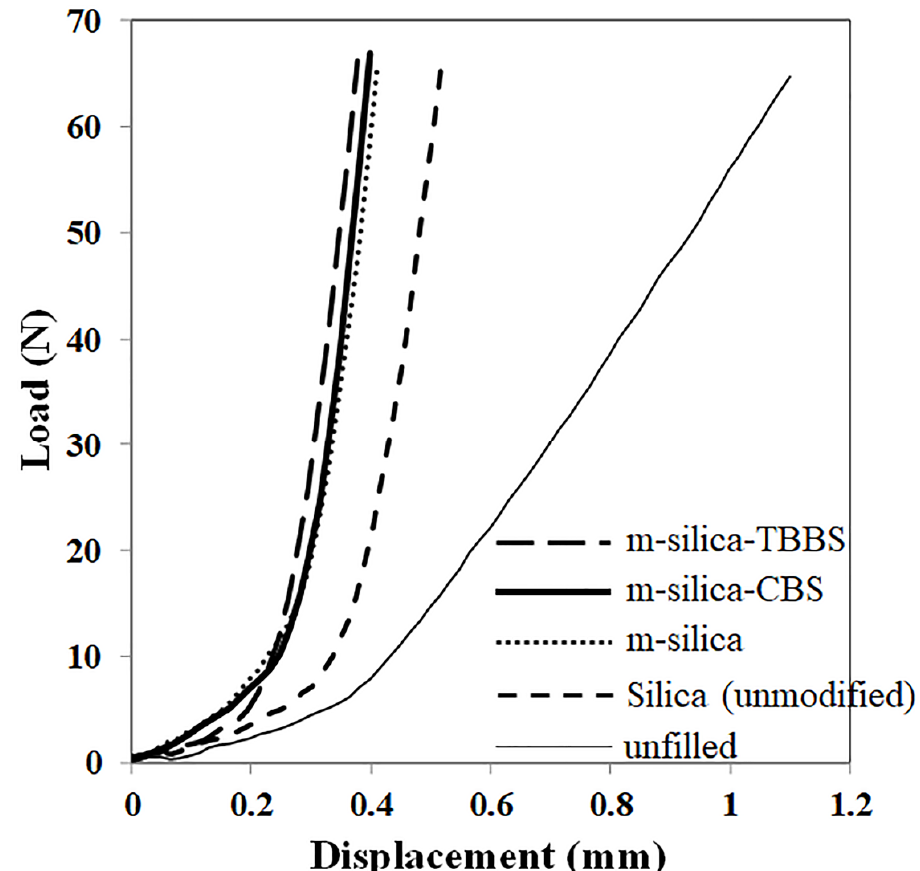
Figure 6. Load versus displacement graphs of rubber rail pads. Table 6. The displacement and the static spring of rubber rail pads.